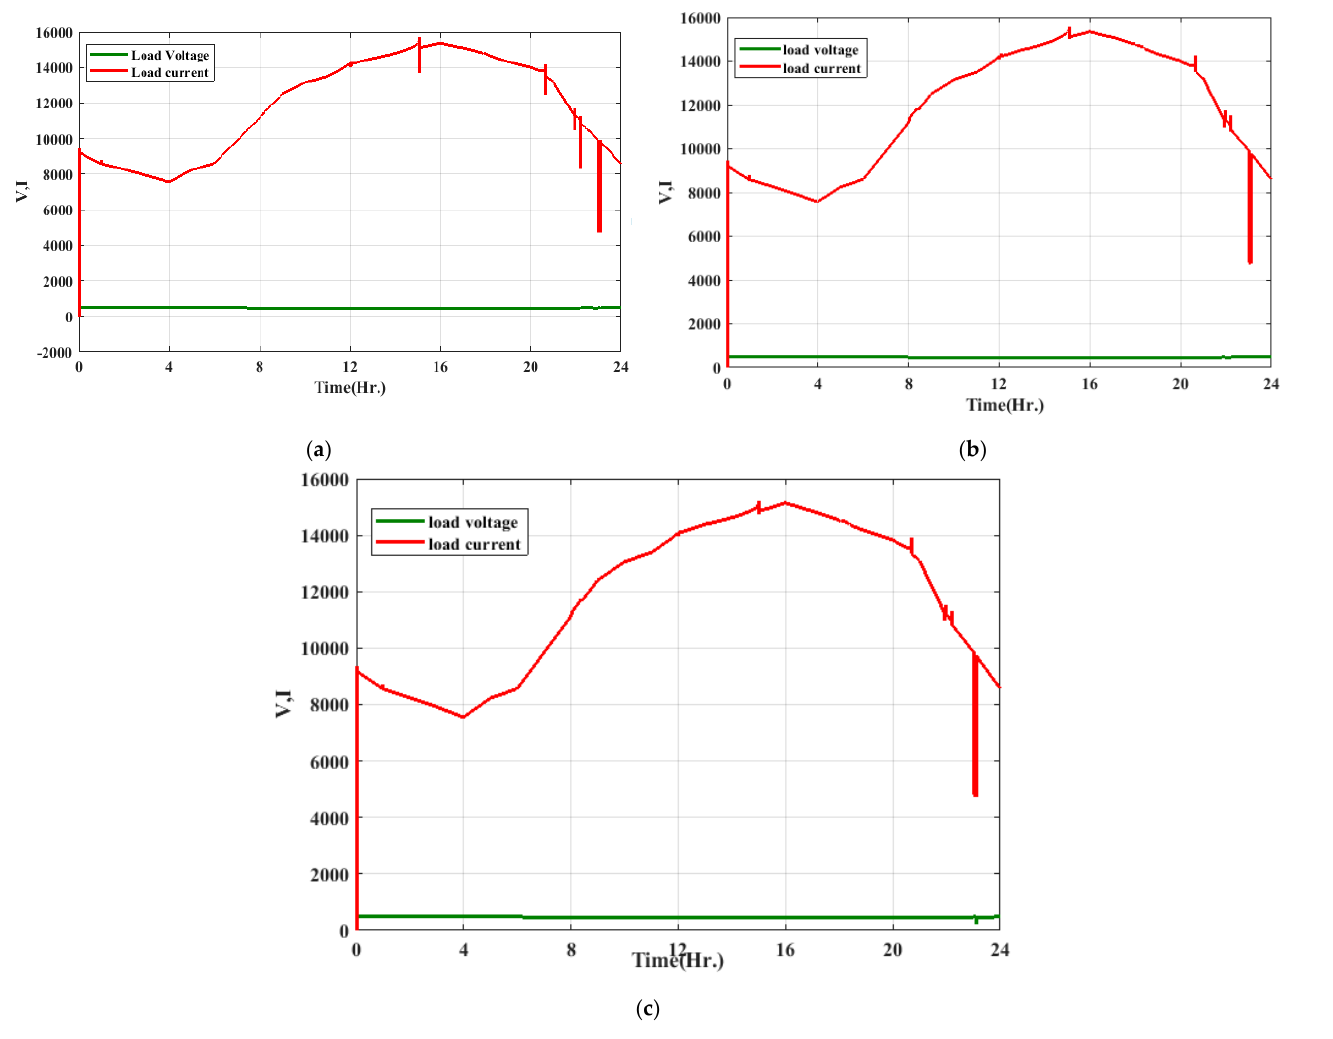
Figure 13. Total Load Voltage and Current; ( a ) without any compensations; ( b ) with V2G compen- sations; and ( c ) with DSTATCOM and V2G compensations.